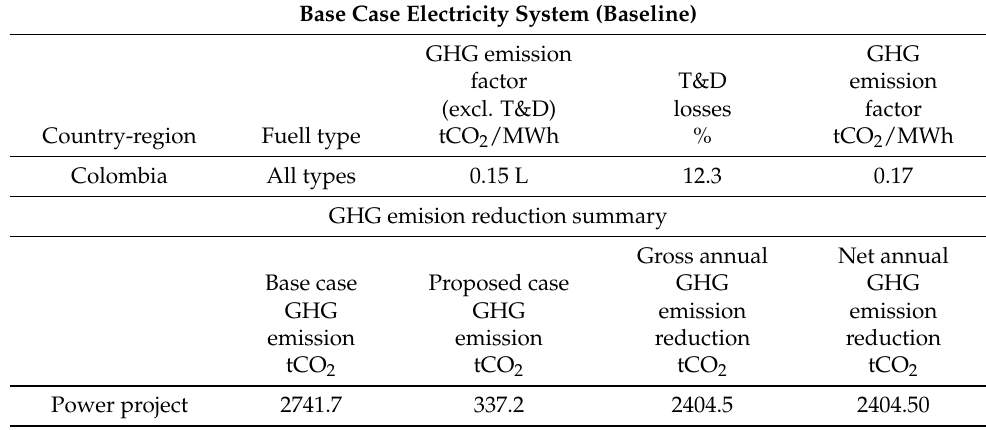
Table 5. Emissions analysis. Net annual GHG emission reduction 2404 tCO 2 is equivalent to 1,032,932 L of gasoline not consumed. Base Case Electricity System (Baseline) GHG